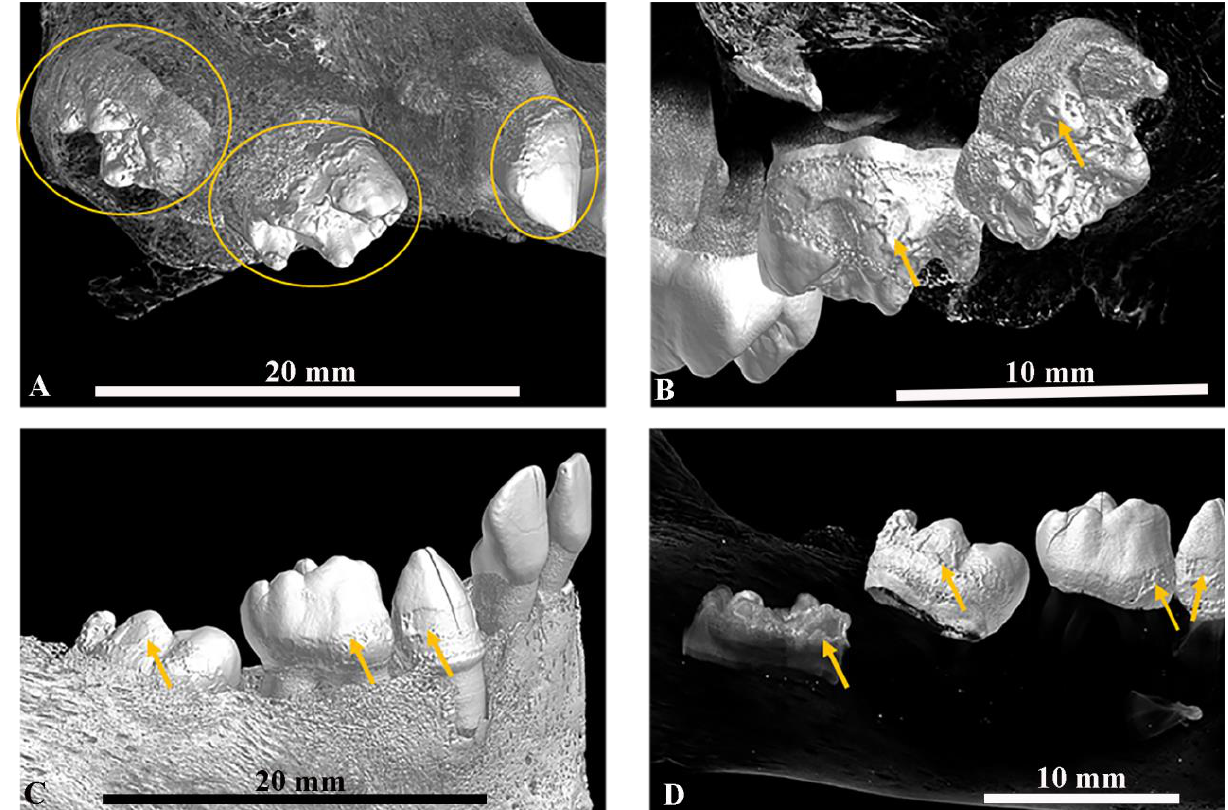
Figure 4. SMB 58 — Infant (dental age range between 1 – 1.5 ± 3 months, skeletal assessment age range between 0 – 2. years of age). (Cranium — Large Volume Micro-CT scanned at 35 µm/pixel and mandible at 21 µm/pixel, Table S2). ( A , B , D ) : Created using Avizo 9 software [30]; the bone density threshold level was manipulated/reduced to reveal the denser structures of the developing teeth within the alveolar bone. ( A ): Buccal view of the semi-erupted, upper-right primary canine and primary second molar; the first primary molar was lost post-mortem. Yellow circles show teeth affected by enamel hypoplastic defects, including the developing crown of the permanent upper right first molar within the alveolar bone. ( B ): Lingual/palatal view of the upper-left primary first and second molars and the crown of the permanent first molar within the alveoli. Yellow arrows highlight enamel hypoplastic defects. ( C ). Lateral view of the mandibular primary dentition. Yellow arrows indicate some enamel hypoplastic defects on the primary canine, first molar, and erupting second molar. ( D ): As with image B, the bone density threshold level was changed to show the developing teeth within the alveoli — yellow arrows show the enamel hypoplastic defects of the erupted primary teeth, semi-erupted primary second molar, and the cusps of the developing crown of the permanent first molar. © Angela Gurr.